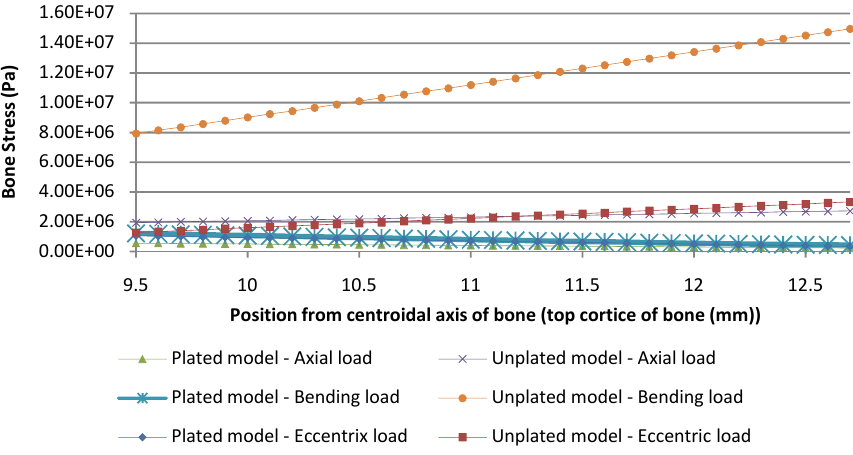
Fig.7 Comparison of bone stresses for the control and the fixed bone